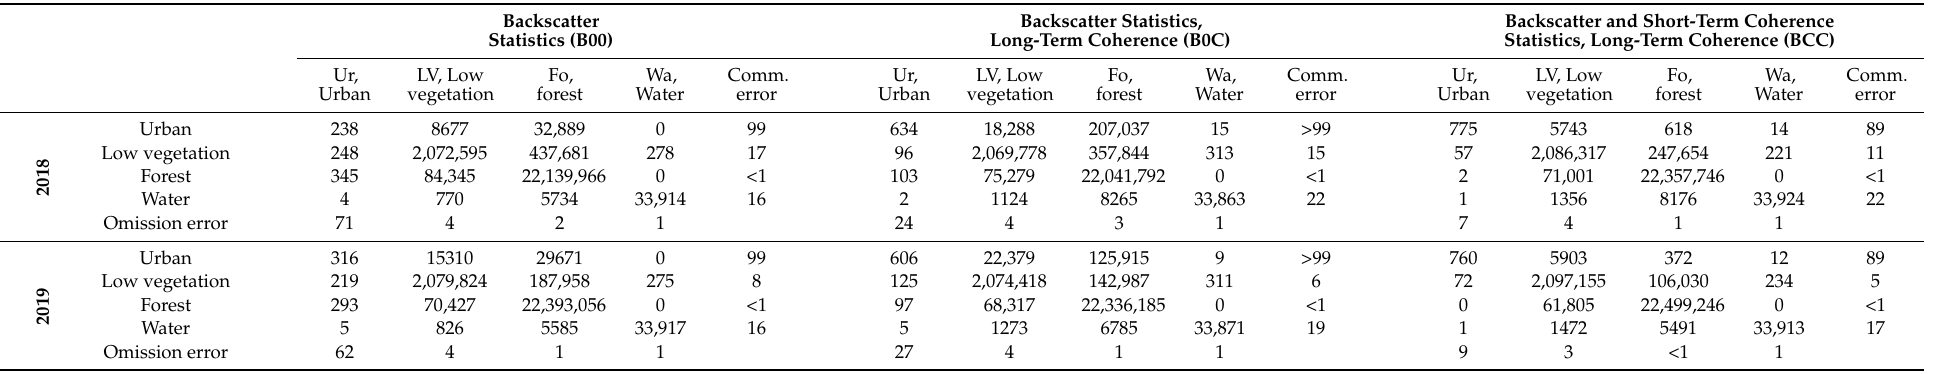
Table A3. Tropical site confusion matrices by year and feature set (Reference > columns; Classified > Rows) compared to the land cover validation dataset (comm. stands for